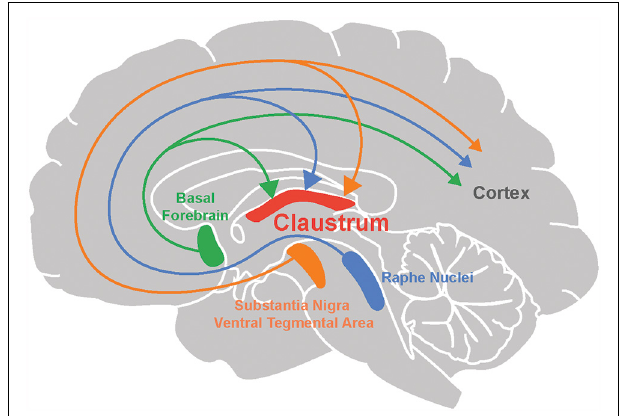
FIGURE 1 | Neuromodulation of the claustrum. The claustrum, as well as the cortex, receives neuromodulatory input from the basal forebrain (acetylcholine), raphe nuclei (serotonin), substantia nigra and ventral tegmental area (dopamine).